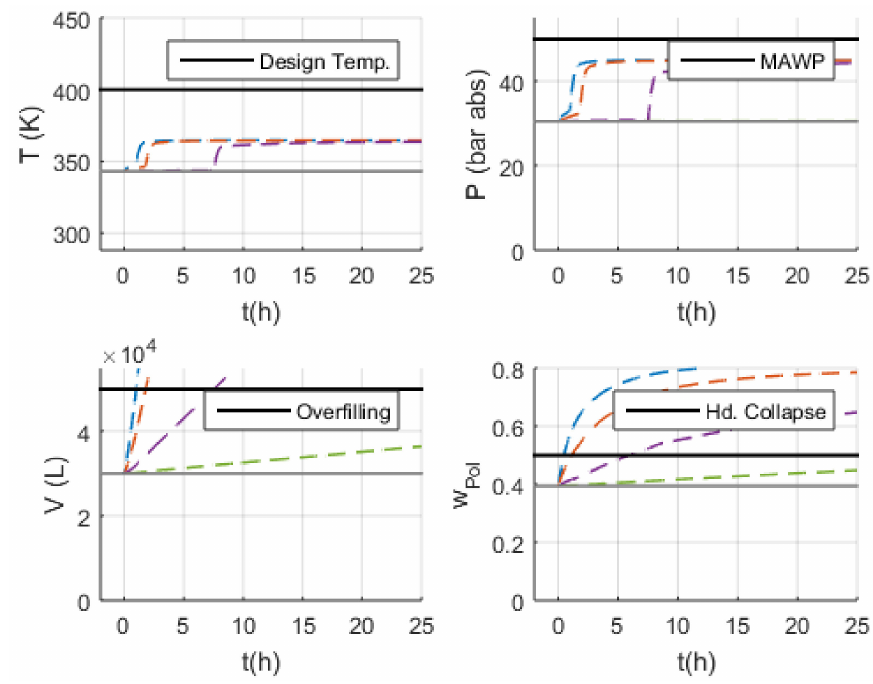
Figure 27. Behavior of critical variables in scenarios S-29 and S-30 with Model 2. Slurry mass